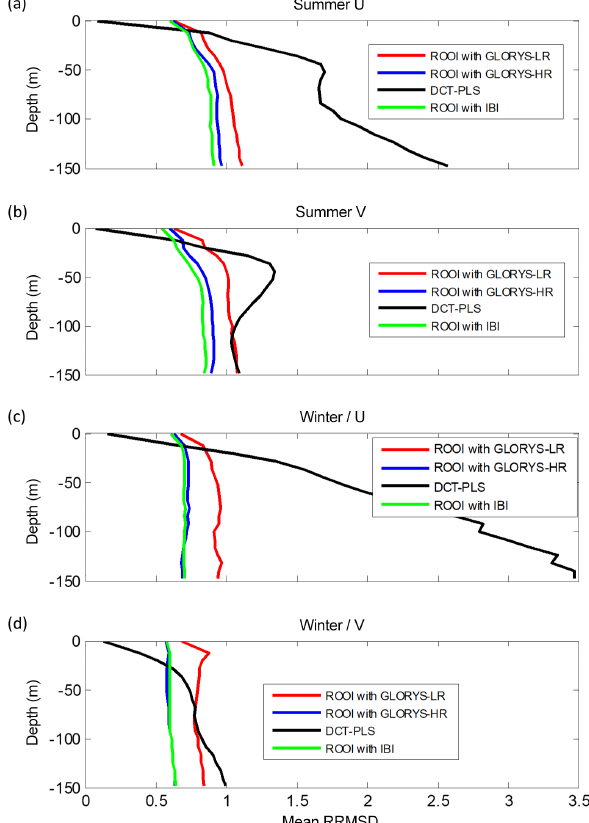
Figure 10. Mean RRMSDs related to all the data-reconstruction methods for each depth considering the entire grid for the summer period (a, b) and for the winter period (c, d) . U is shown in (a, c) and V in (b, d) .